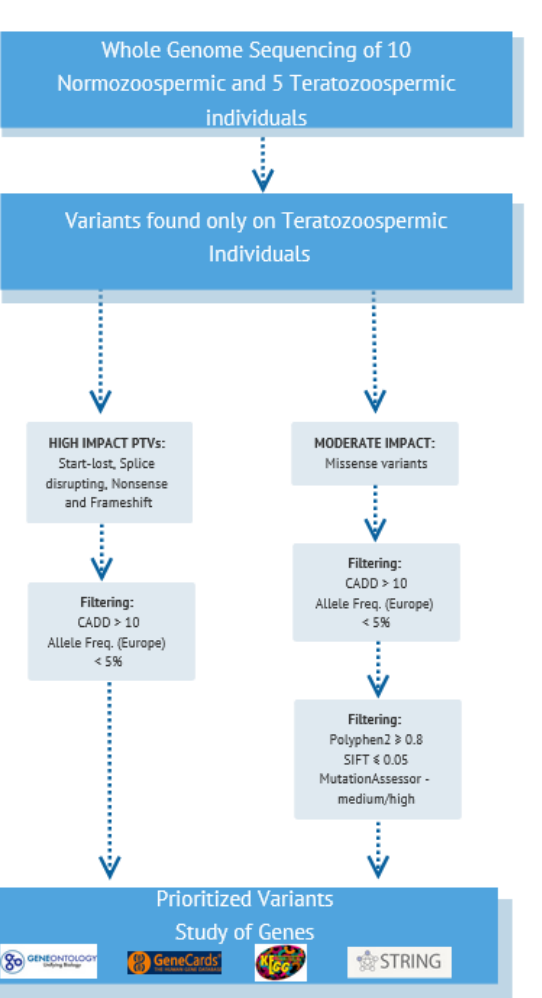
Figure 1. The pipeline used to filter variants found in Greek patients with teratozoospermia. At first, high and moderate impact variants were selected and then, bioinformatics tools were used to assess their impact on protein structure, function, and conservation. Genes on which the prioritized variants were found were further evaluated using several other databases (Gene Ontology; http://geneontology.org/, accessed on 26 June 2022, GeneCards; https://www.genecards.org/, accessed on 26 June 2022, KEGG; https://www.genome.jp/kegg/, accessed on 26 June 2022 and STRING; https://string-db.org/, accessed on 26 June 2022). (a): High Impact variants [31]. At first, protein-truncating variants (PTVs) that lead to a truncated protein or its complete absence and thus, can have a severe consequence on protein function [32], as they have been associated with the causing of several diseases according to studies [33], were selected. The PTVs that were prioritized in this study in- cluded nonsense single-nucleotide variants (SNVs), frameshift insertions or deletions (in- dels), splice-disrupting variants, and start-loss SNVs. Common variants with an allele fre- quency > 0.05 according to data retrieved from the 1000 Genomes Project [25] for the Eu- ropean population as well as from the gnomAD database [26] for Non-Finnish Europeans were excluded. This filter was also applied because the aim was to identify rare variants. According to studies, rare variants can help to shed light on common diseases as they are not found frequently in the population, and thus, there is a greater possibility to be